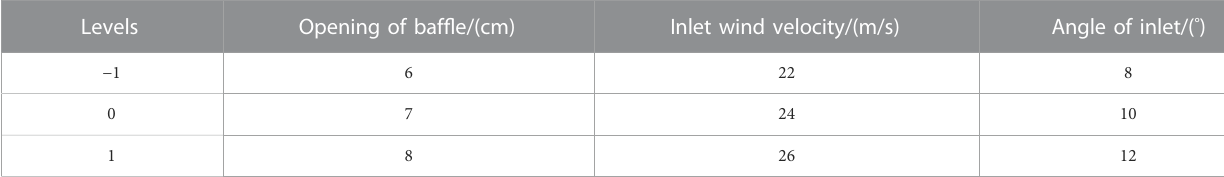
TABLE 2 Test factors horizontal coding table. Levels